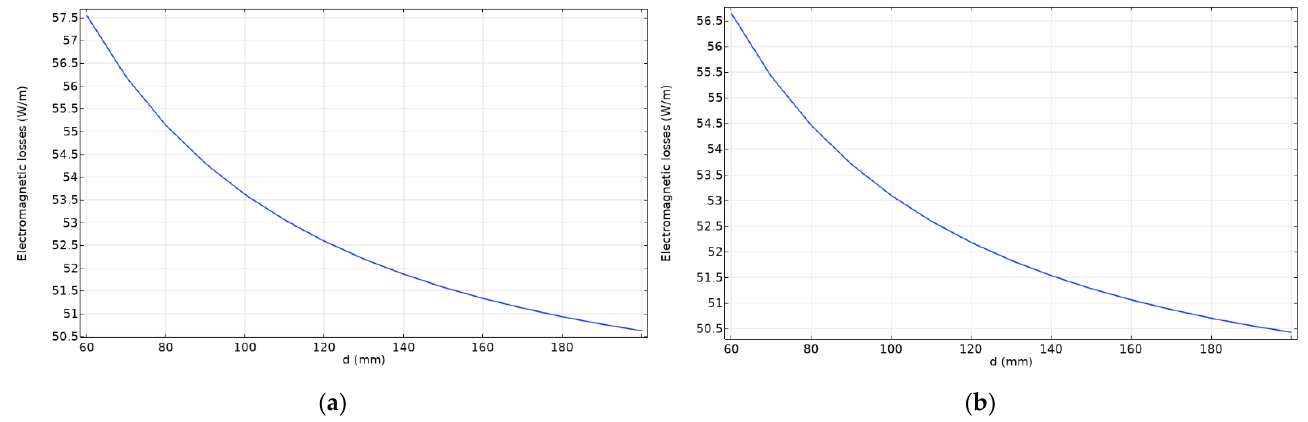
Figure 12. Electromagnetic heating against the phase-to-phase distance at 60 Hz for: ( a ) Model 5; ( b ) Model 6.